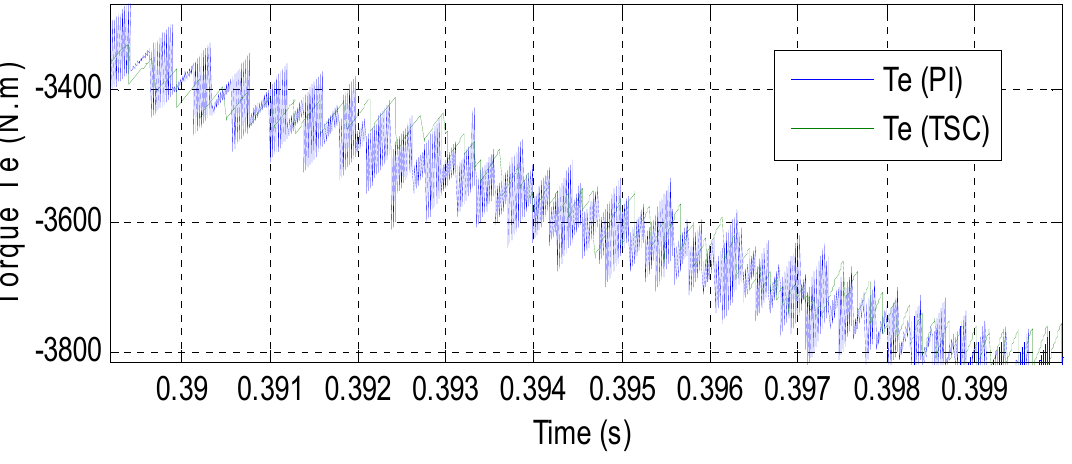
Figure 22. Zoom (Torque).